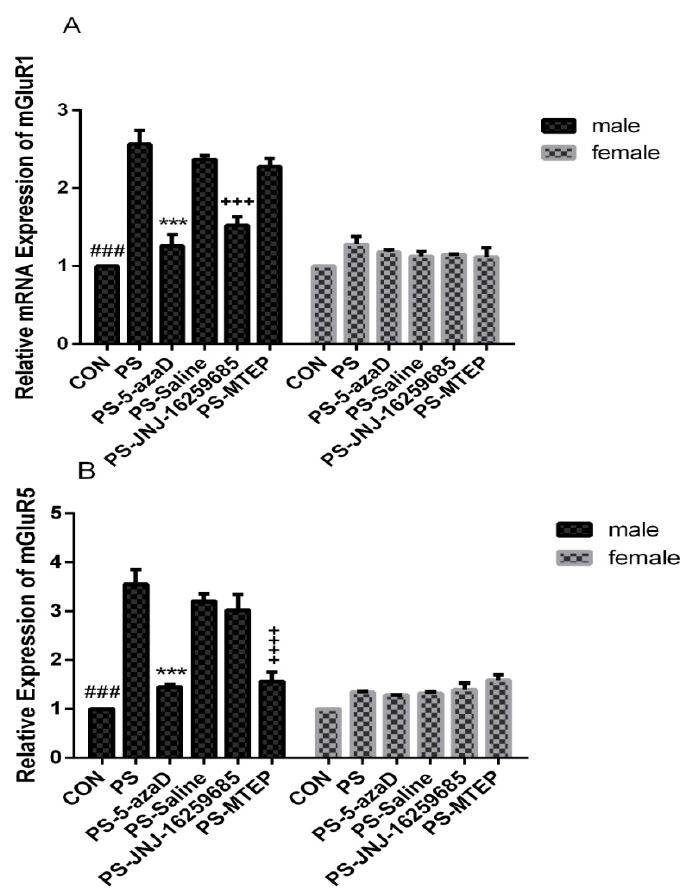
Figure 2. The depression-like behavior test of OR. ( A ) Sucrose preference in PS induced OR; ( B ) Immobility time in PS induced OR; ( C – E ) Center time, rearing, and frequency of micturition shown in six groups ( n = 8 each group). Data is expressed as mean ± SEM. ### p < 0.001, ## p < 0.01, # p < 0.05 compare with CON and *** p < 0.001, ** p < 0.01, * p < 0.05 compare with PS. +++ p < 0.001, + p < 0.05 compare with PS.